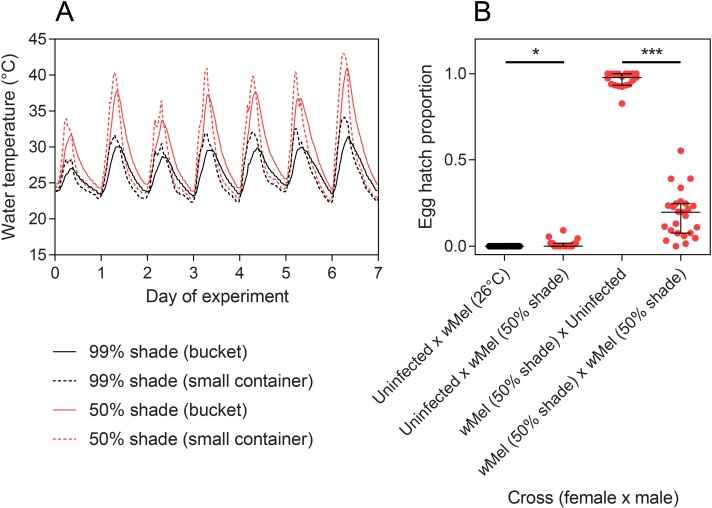
Temperature cycles and the resulting egg hatch proportions from crosses in the second field experiment.(A) Temperature cycles experienced in buckets (8 L) and small containers (400 mL) from the 26th of January to the 1st of February 2018. (B) Egg hatch proportions of crosses with wMel-infected adults when larvae were reared in buckets under 50% shade. All error bars are medians with interquartile ranges. * P < 0.05, *** P < 0.001 by Mann-Whitney U test.